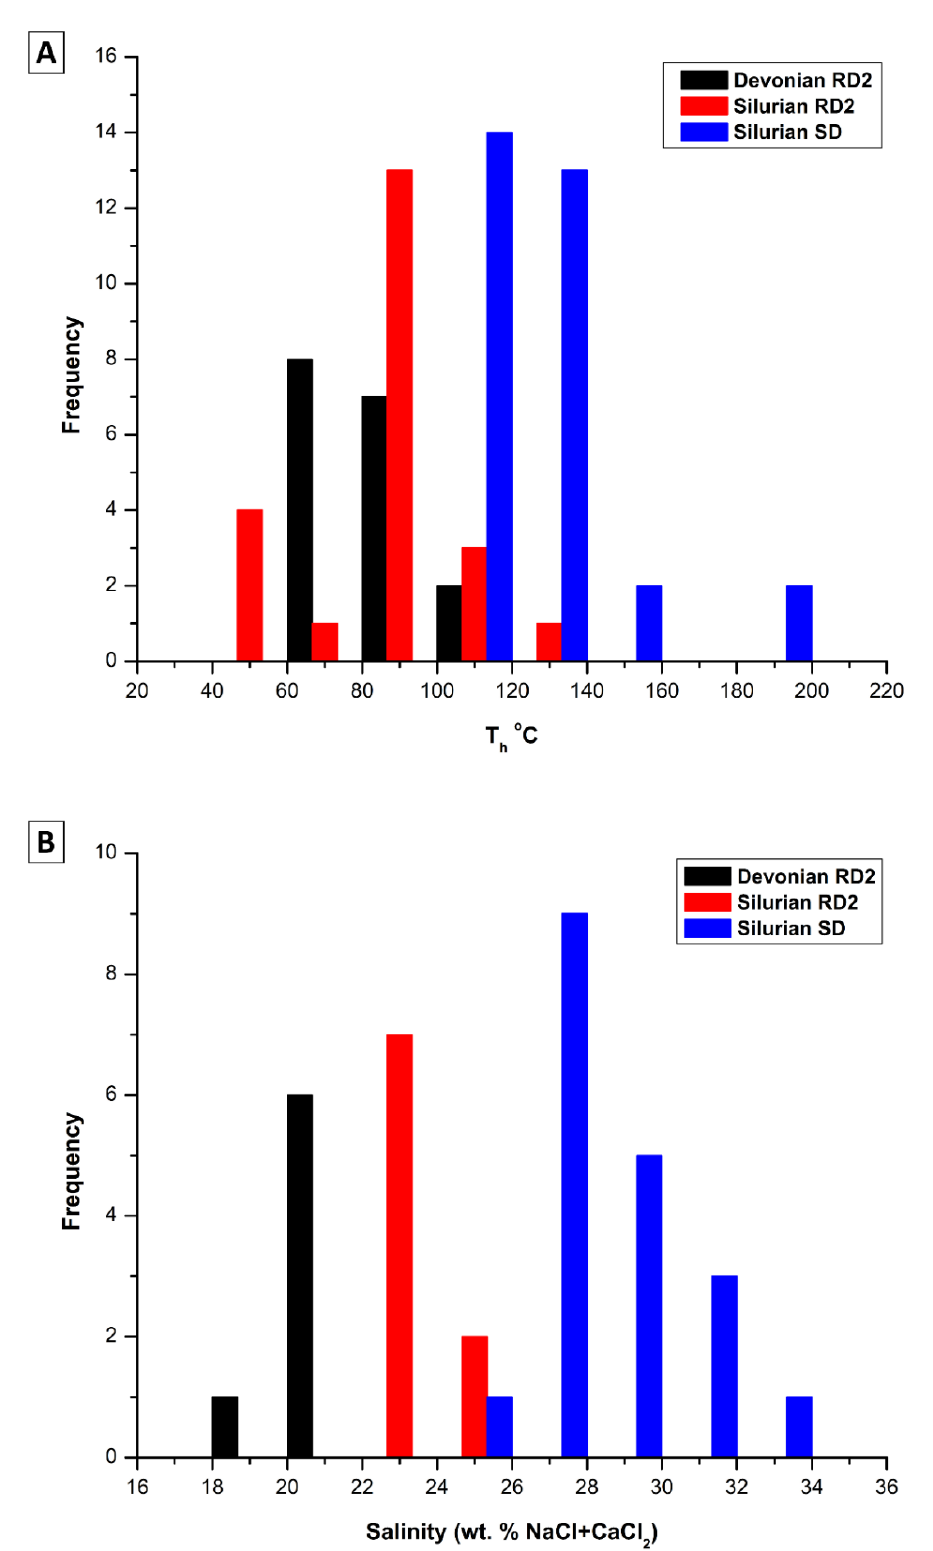
Figure 15. Histogram plots of ( A ) homogenization temperature and ( B ) salinity for analyzed dolomite phases in Silurian and Devonian formations.